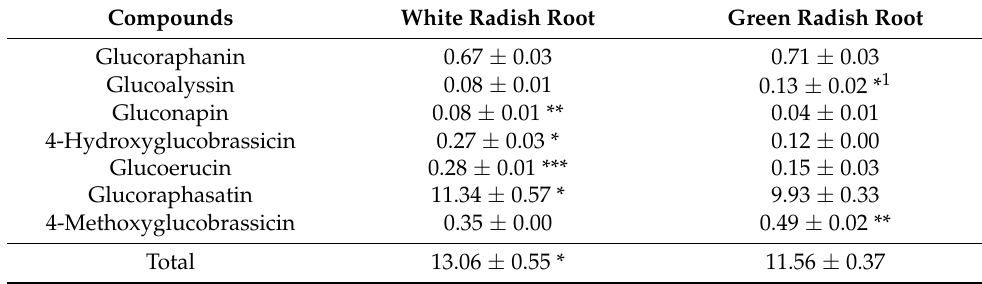
Table 1. Glucosinolate content in white and green radish cultivars ( µ g g − 1 ). Compounds White Radish Root Green Radish